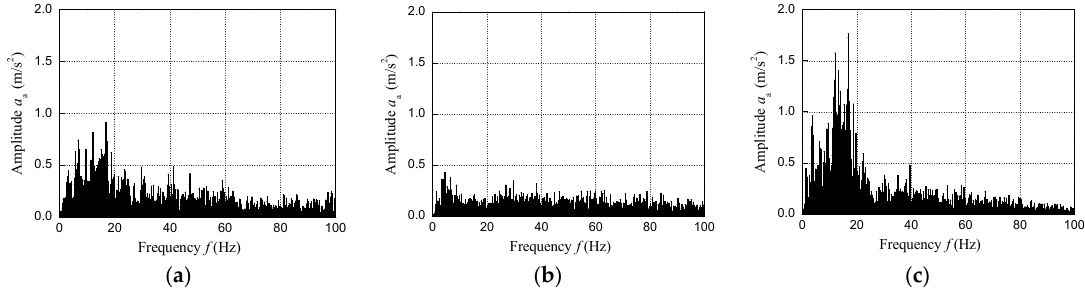
pear not only on the z -axis but also on the x -axis in the direction of bicycle’s motion.